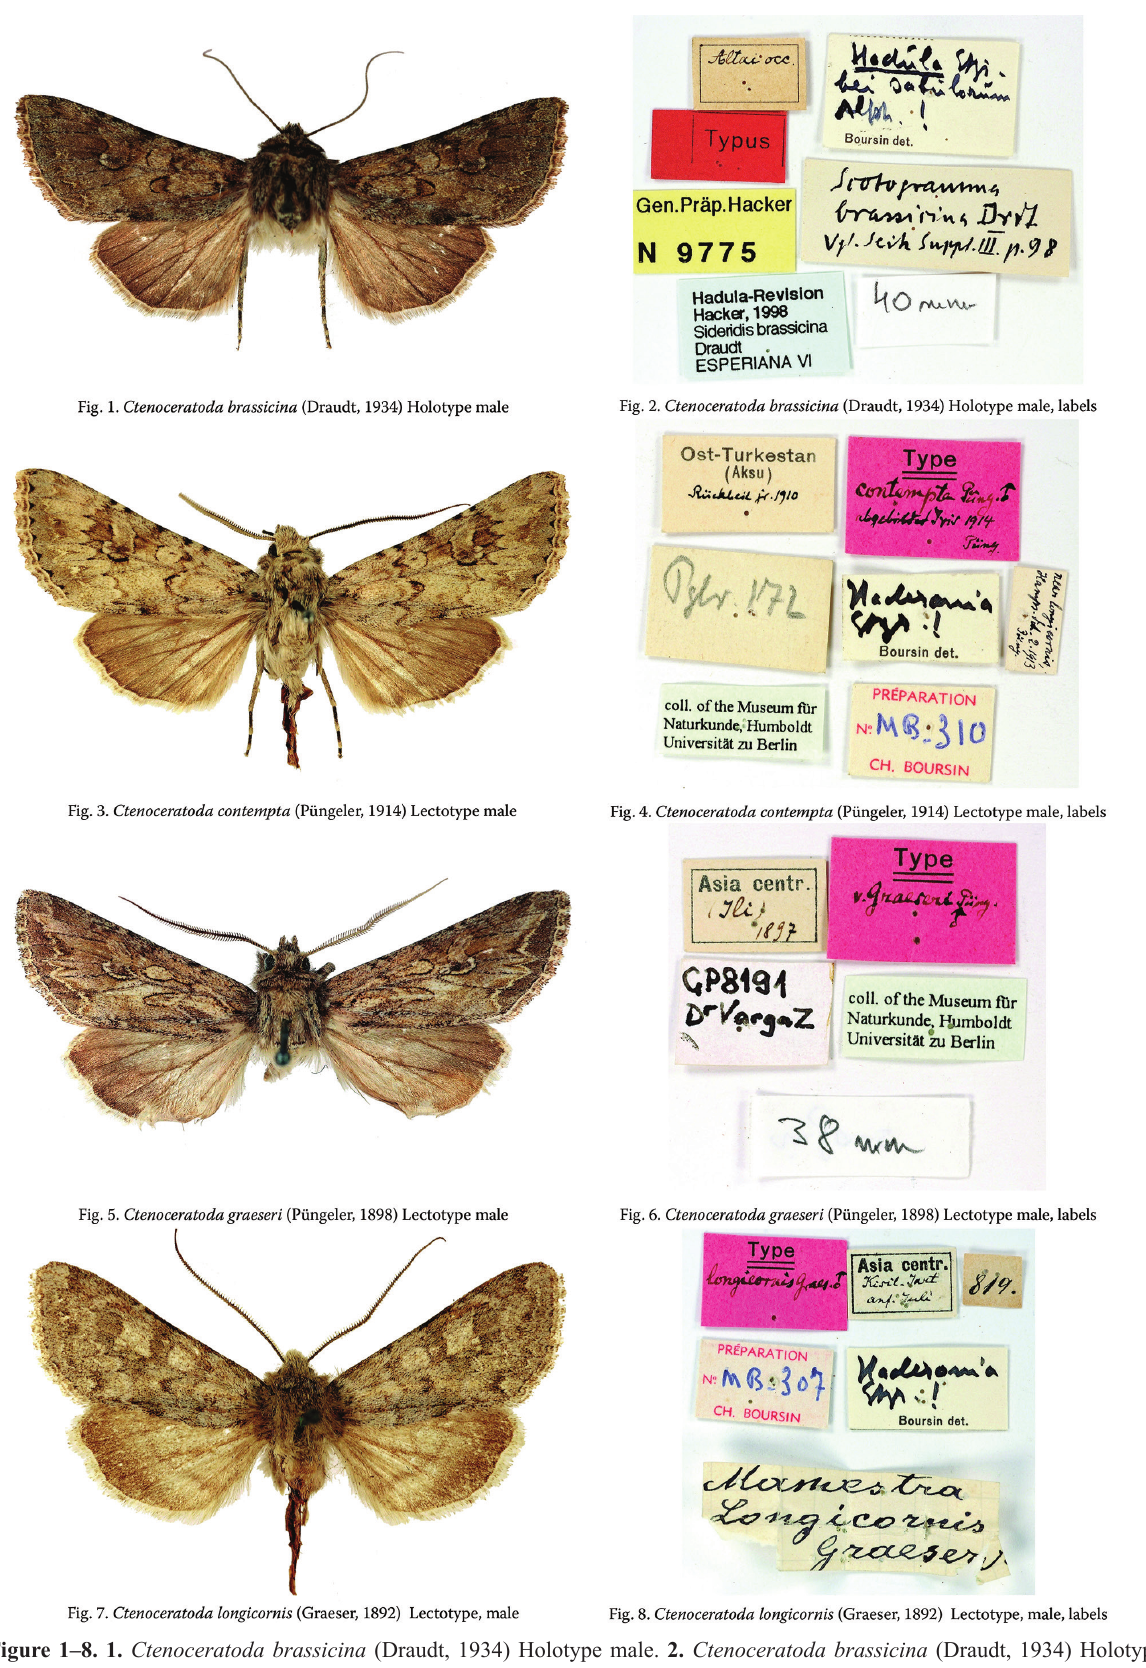
Figure 1–8. 1. Ctenoceratoda brassicina (Draudt, 1934) Holotype male. 2. Ctenoceratoda brassicina (Draudt, 1934) Holotype male, labels. 3. Ctenoceratoda contempta (Püngeler, 1914) Lectotype male. 4. Ctenoceratoda contempta (Püngeler, 1914) Lecto- type male, labels. 5. Ctenoceratoda graeseri (Püngeler, 1898) Lectotype male. 6. Ctenoceratoda graeseri (Püngeler, 1898) Lec- totype male, labels. 7. Ctenoceratoda longicornis (Graeser, 1892) Lectotype, male. 8. Ctenoceratoda longicornis (Graeser, 1892) Lectotype male,